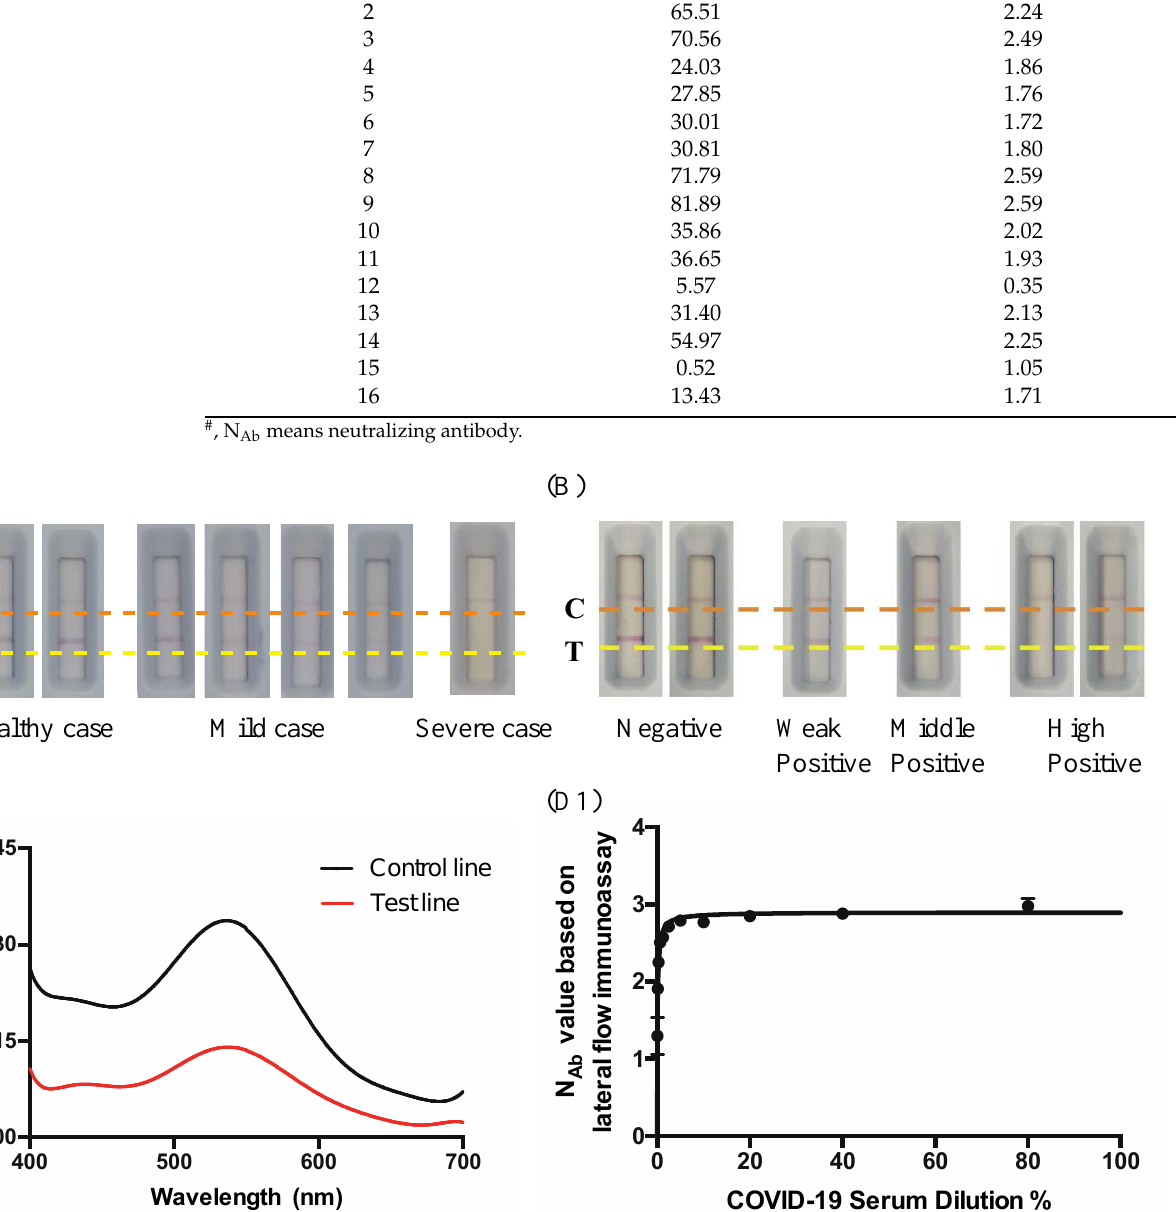
Figure 2. ( A ) SARS-CoV-2 Neutralizing Antibody Rapid Test Cassette (coupled with a spectrum- based reader) loaded with different COVID-19-confirmed cases. Control line region shown as an orange dotted line; test line region shown as a yellow dotted line. ( B ) SARS-CoV-2 Neutralizing Antibody Rapid Test Cassette (coupled with a spectrum-based reader) loaded with samples from different vaccinated individuals. Control line region shown as an orange dotted line; test line region shown as a yellow dotted line. ( C ) The reflectance spectra of a mild case, with the reflectance spectra of the control line region shown as a black solid line; the reflectance spectra of the test line region shown as a red solid line. The x -axis is the unit of wavelength (nm). The y -axis is the arbitrary unit (AU). ( D1 ) Testing the N Ab value based on the lateral flow immunoassay with a dilution series of a severe case patient’ s serum. Curve fit by the Hill equation (R-squared = 0.9582), and ( D2 ) is part of ( D1 ) (R-squared = 0.9649). ( E ) Comparison of the N Ab value based on the lateral flow immunoassay